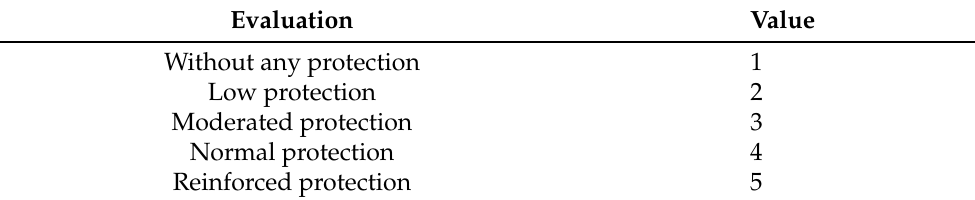
Table 1. Threat evaluation criterion.